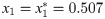
Evolutionarily stable coexistence of a dimorphic predator species.(a) Traits coevolution plot when a2 = 2.21, m2 = 1.12. The vector fields obtained from deterministic Model (9) indicate directions of coevolution of traits x1 and x2. The black curve and red curve indicate respectively isoclines of traits x1 and x2. The solid curves indicate evolutionarily singular strategies which are evolutionarily stable, while the dashed curve indicates evolutionarily singular strategy which is not evolutionarily stable. The grey region is feasible phenotype space, in which predator-prey coevolution can occur. (b) Pairwise invasibility plot (PIP) for fixed prey strategy x1=x1*=0.507. (c) Mutual invasibility plot (MIP) for fixed prey strategy x1=x1*=0.507. (d) Simulated evolutionary tree obtained through simulation of Models (9) and (29) with initial condition (x1, x2) = (0.3, 0.8) and a2 = 2.21, m2 = 1.12. (e) Fitness landscape plots when (x1*,x21*,x22*)=(0.498,0.45,0.093) and a2 = 2.21, m2 = 1.12. (f) Equilibrium population densities of prey species along the coevolutionary trajectory. The red curve indicates total equilibrium population density of the two prey species. (g) Equilibrium population density of predator species along the coevolutionary trajectory. Parameter values: μ1 = μ2 = μ21 = μ22 = 0.03, σ1 = σ2 = σ21 = σ22 = 0.03. The other parameter values are the same as described in Figs 1 and 2.